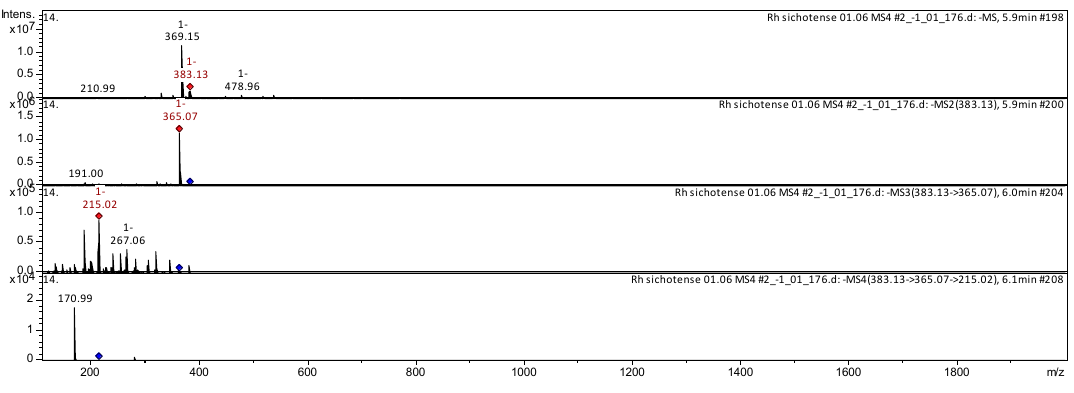
Figure 3. CID spectrum of fraxetin-7- O -beta-glucoronide from Rh. sichotense , m/z 383.13.